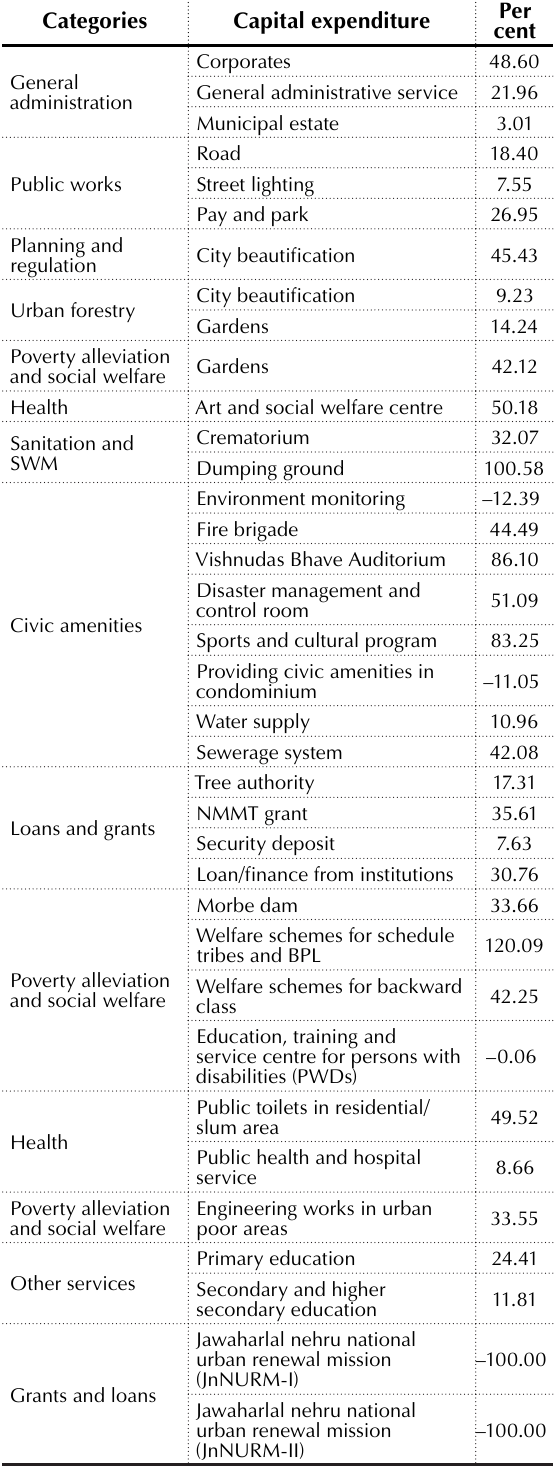
Table 5. The capital expenditure of Navi Mumbai Municipal Corporation (CAGR) (from 2000–2001 to